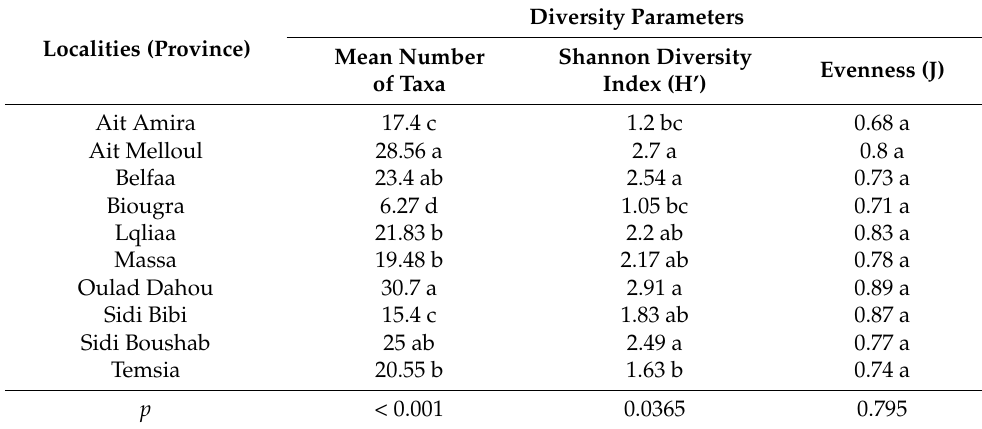
Table 4. Diversity of nematode communities of wheat in the different surveyed localities. Localities